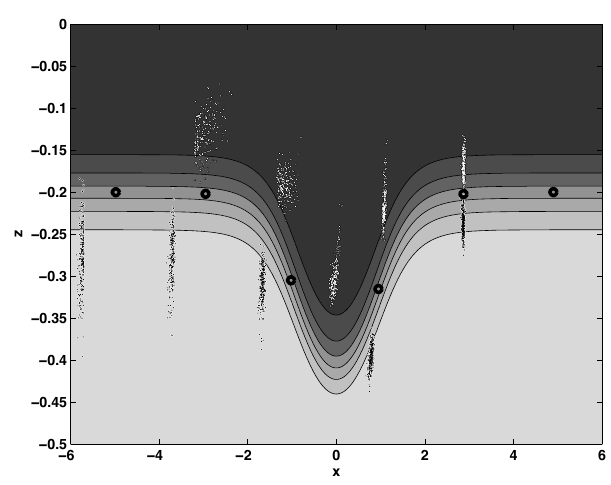
Fig. 4. Plot of the outliers of a 10000 member ensemble of parti- cles initially located upstream of the ISW and at the center of the pycnocline superimposed on a shaded plot of density contours. Un- perturbed location of particle indicated by thick black circle. See text for detailed